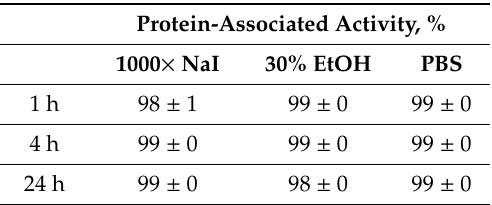
Table 3. In vitro stability of [ 125 I]I-PIB-Ec1.